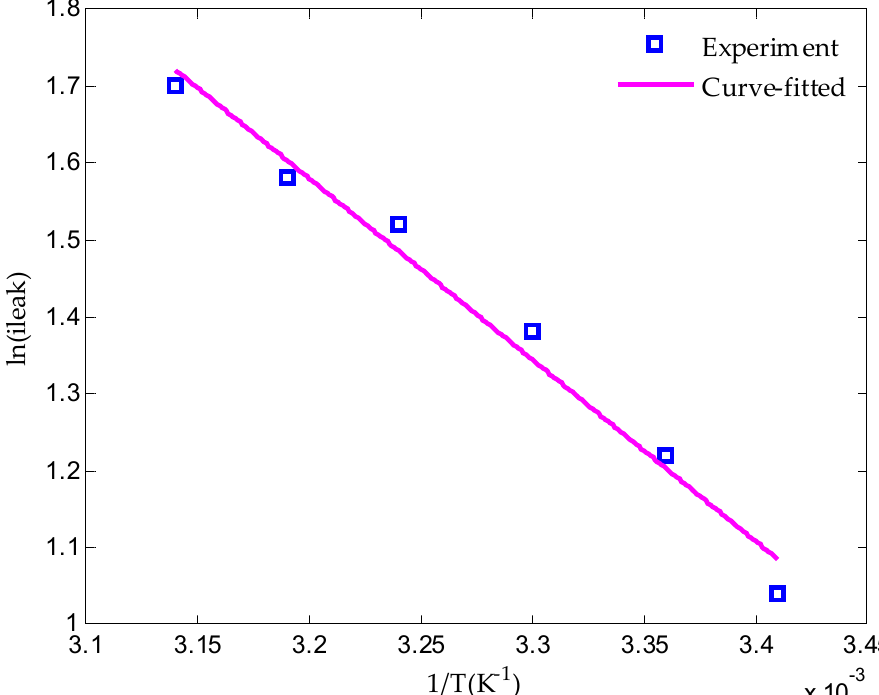
Figure 2. Relationship between leakage current density and operating temperature.